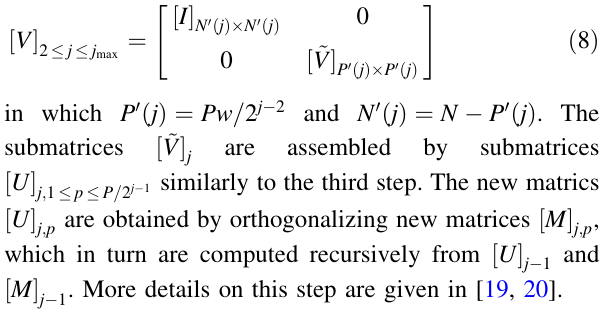
where the wavelet order is w ¼ 3 such that the mesh is divided into P ¼ 8 bins and exhibits j max ¼ 4 detail levels. The mesh is is the j . Shown are matrices i (cid:3) j